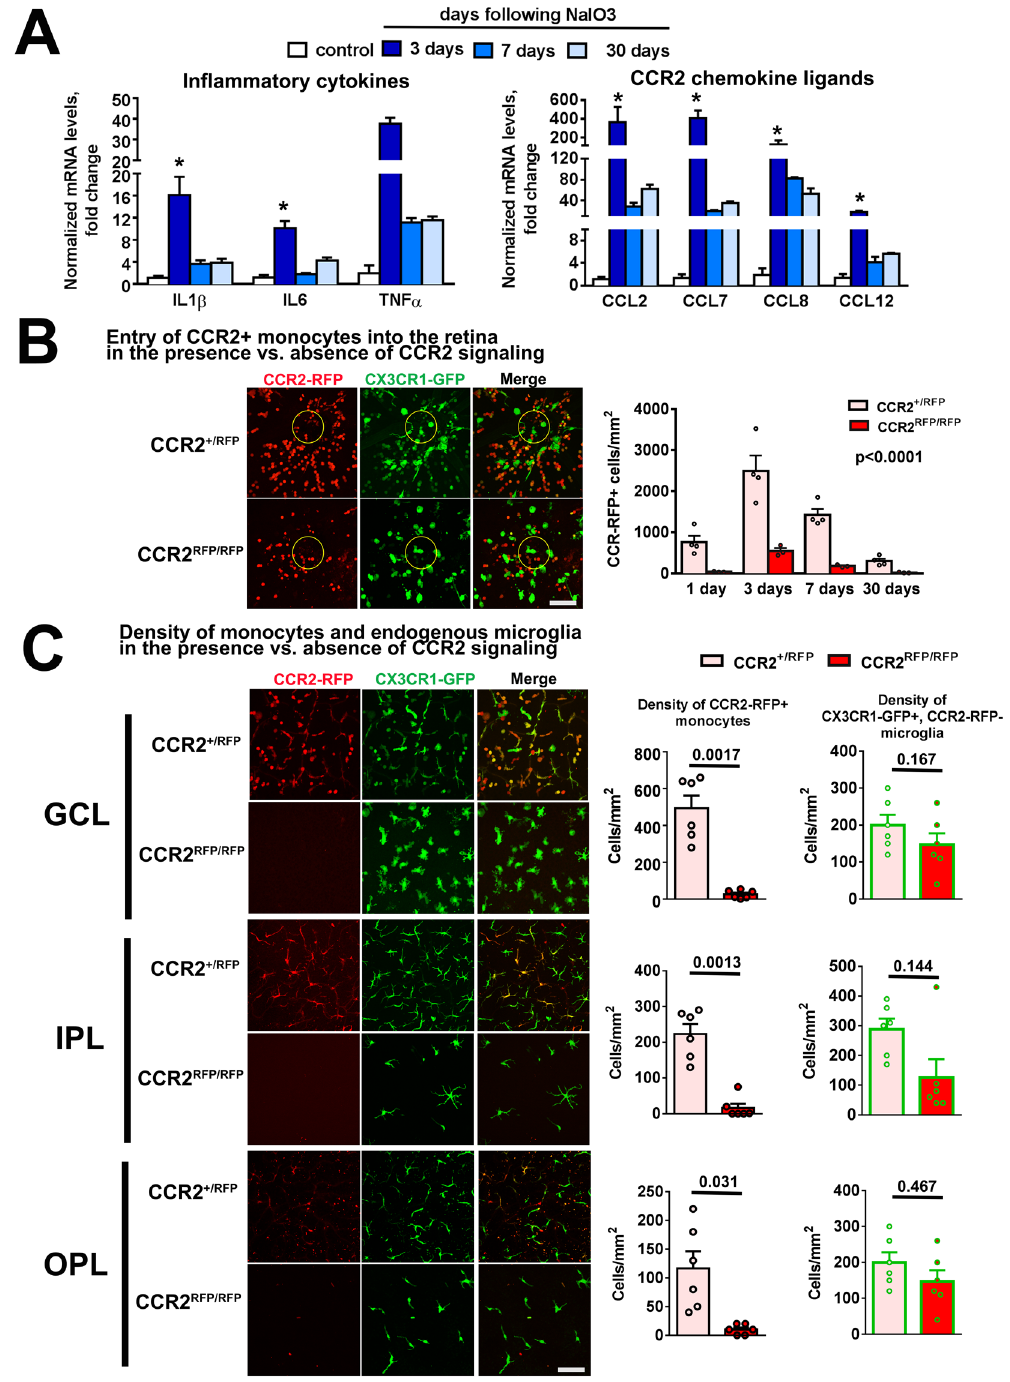
Figure 5. CCR2 signaling regulates monocyte entry and repopulation of the inner retina induced by RPE injury. ( A ) mRNA expression of inflammatory cytokines (IL-1 β , IL6, and TNF- α ) and chemokine ligands to CCR2 (CCL2, CCL7, CCL8, and CCL11) as measured by rtPCR were significantly upregulated 3 days following NaIO 3 -mediated RPE injury relative to uninjured controls and declined thereafter. The increases in expression were greatest for CCL2 and CCL7. ( * Indicates p < 0.05 for comparisons relative to control, Kruskal-Wallis test with Dunn’s multiple comparisons test, n = 3 independent replicates per group.) ( B ) The entry of CCR2 + monocytes into the retina at the location of the optic nerve head (indicated by yellow circle ) was monitored in CX3CR1 GFP/ + , CCR2 RFP/ + and CX3CR1 GFP/ + , CCR2 RFP/RFP transgenic mice in which CCR2-mediated signaling was preserved and ablated respectively. In CCR2 RFP/ + mice, CCR2 + monocytes appeared at the optic nerve at 1 day after NaIO 3 -mediated RPE injury, and peaked at 3 days before declining thereafter. In CCR2 RFP/RFP mice, changes in CCR2 + monocyte density followed the same temporal pattern but were significantly lower than those in CCR2 RFP/ + mice (p < 0.0001, 2-way ANOVA, n = 3–4 animals for each time point). ( C ) The densities of monocytes in different retinal lamina were examined at 7 days